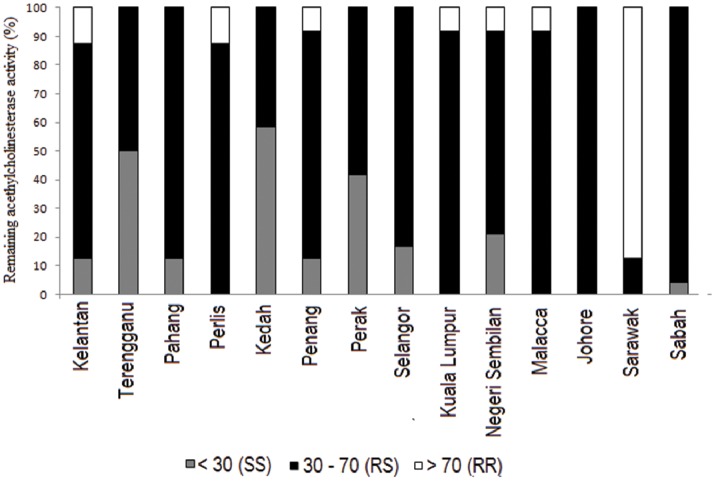
Percentage remaining activity of acetylcholinesterase in individual Malaysian Culex quinquefasciatus after 0.1% propoxur inhibition.*<30% = homozygous susceptible (SS), 30–70% = heterozygous (RS), >70% = homozygous resistance (RR) [40].